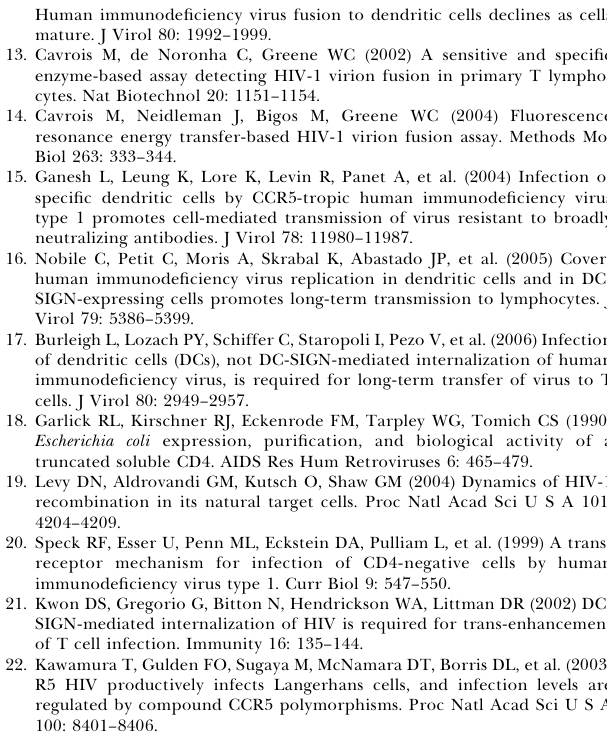
Figure S1. The Virion-Based Fusion Assay Is Sensitive and Quanti- tative in the Context of trans -Infection Serial dilutions of NL4–3 virions containing BlaM-Vpr were bound to immature or mature MDDCs at 4 8 C. After three washes, these HIV-1– loaded MDDCs were incubated with autologous T cells for 2 h. Viral transfer to T cells was determined by measuring the amount of BlaM þ T cells. Figure S2. Changes in Virion Input, Internalization Time, and Viral Strain Fail to Reveal HIV-1 trans -Infection of T Cells from Internal Compartments